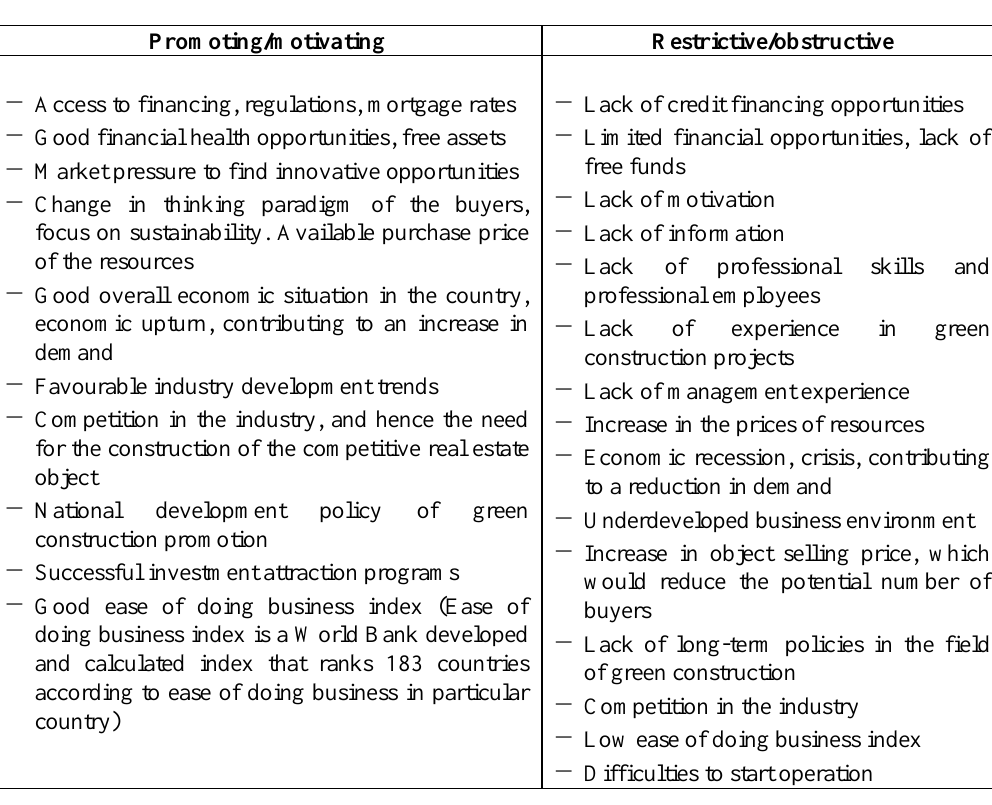
Table 4 . Promoting and restrictive factors of green building investments [developed by